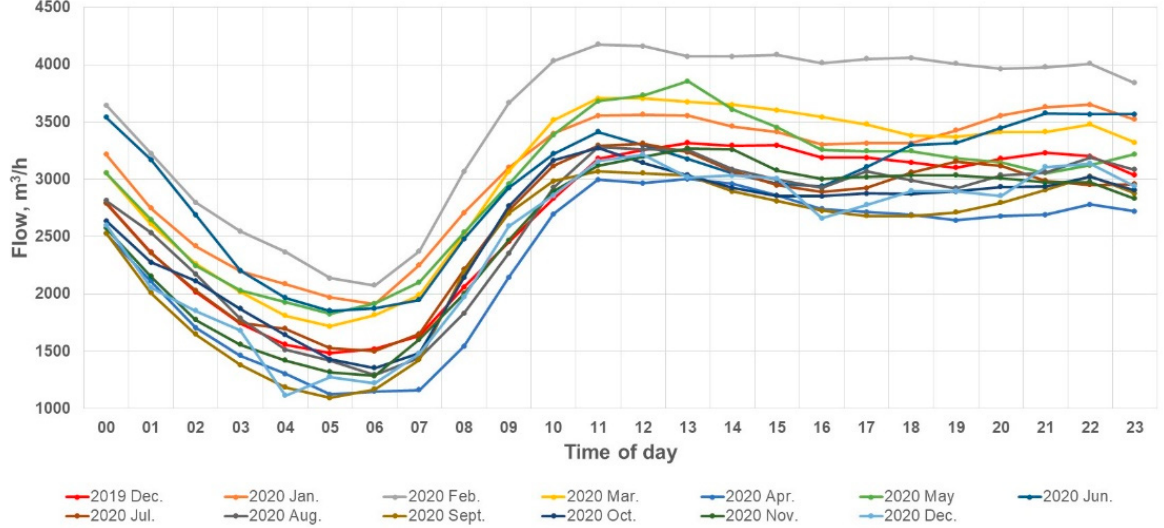
Figure 6. Wastewater hydrograph (22 September to 5 November 2020) perturbated by storm events at Akademija–Marvele (A = 1.5 km 2 , PE = 2400).